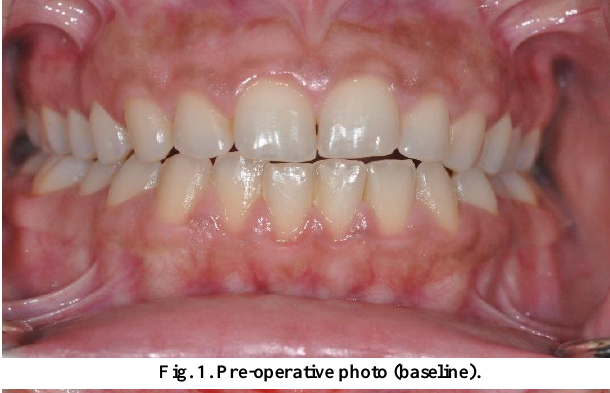
Fig. 1. Pre-operative photo (baseline).